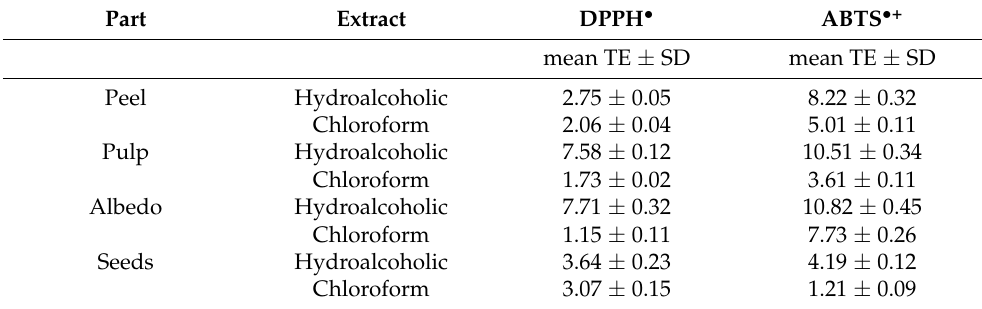
Table 5. DPPH • and ABTS • + radical scavenging capacity of hydroalcoholic and chloroform